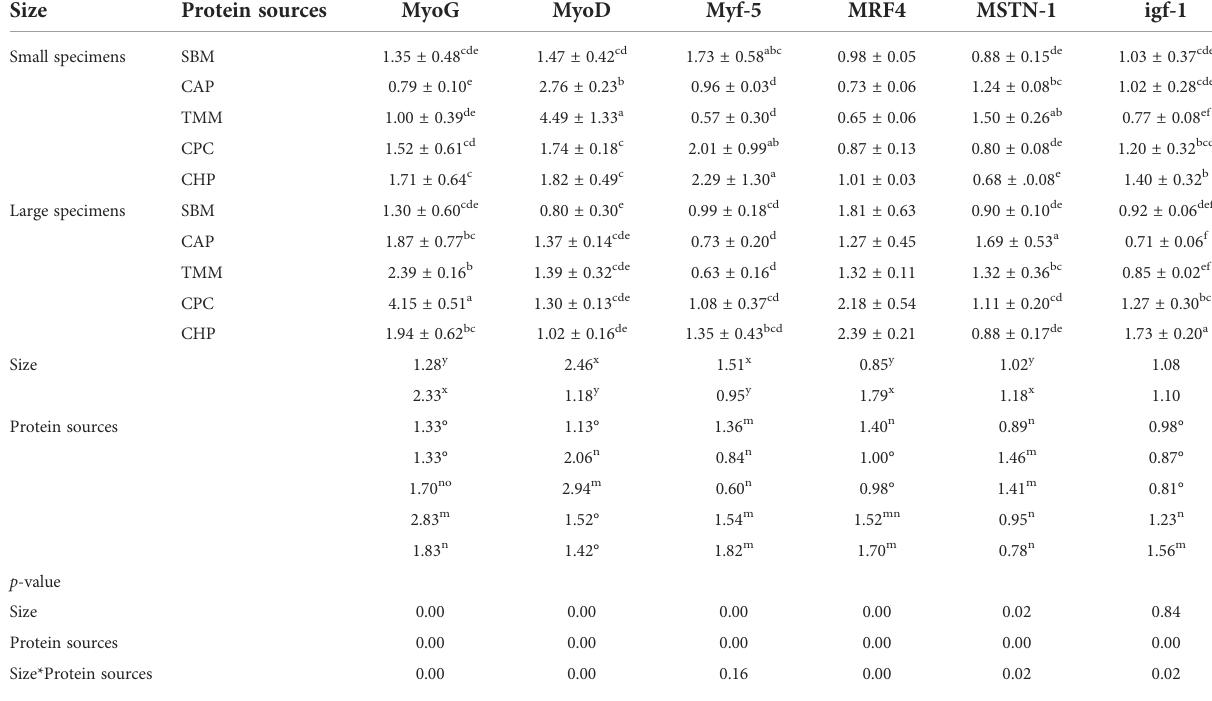
TABLE 10 Related gene expression levels of growth and development in the muscles in different